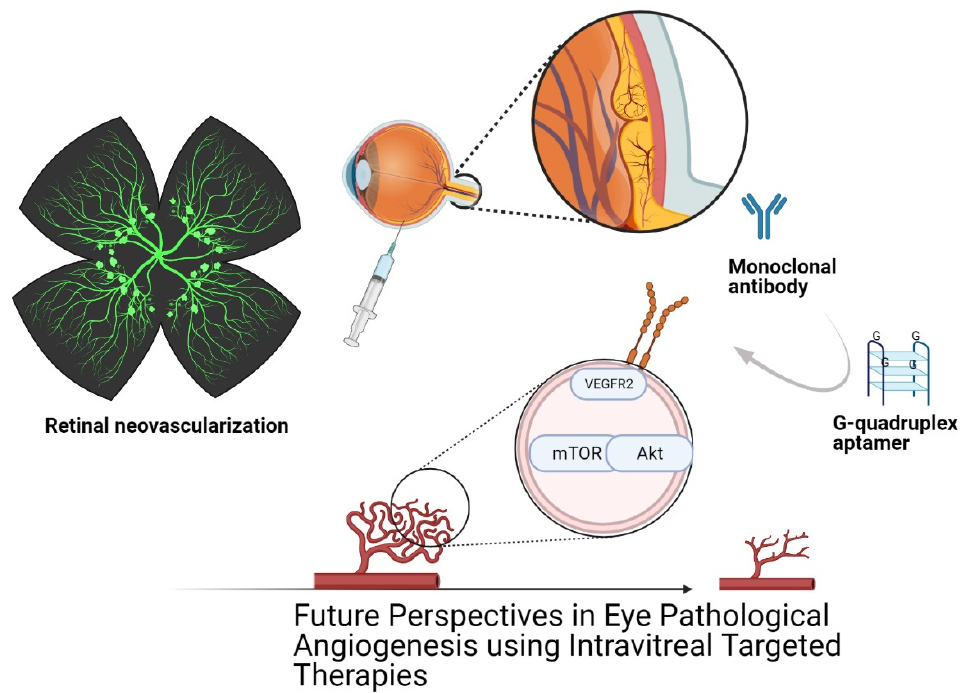
Figure 1. Future perspectives in eye pathological angiogenesis using intravitreal targeted therapy. Schematic retinal flat mount showing neovascularization on the superficial vascular plexus. Intravitreal eye injection is the therapy currently used as a treatment for proliferative diabetic retinopathy, retinopathy of prematurity, age-related macular degeneration and retinal vein occlusion. The treatments currently used focus on blocking the VEGF signaling pathway, and although it has beneficial results in patients, complications occur while inhibiting normal functions. Thus, researchers are looking for specific molecules that are not constitutively expressed that unbalance ocular homeostasis. G-quadruplex aptamers have many advantages compared to immunological therapy, such as lower molecular weight, controllable post-production modifications, non-toxic and non-immunogenic, with lower costs of production. Created with BioRender.com.